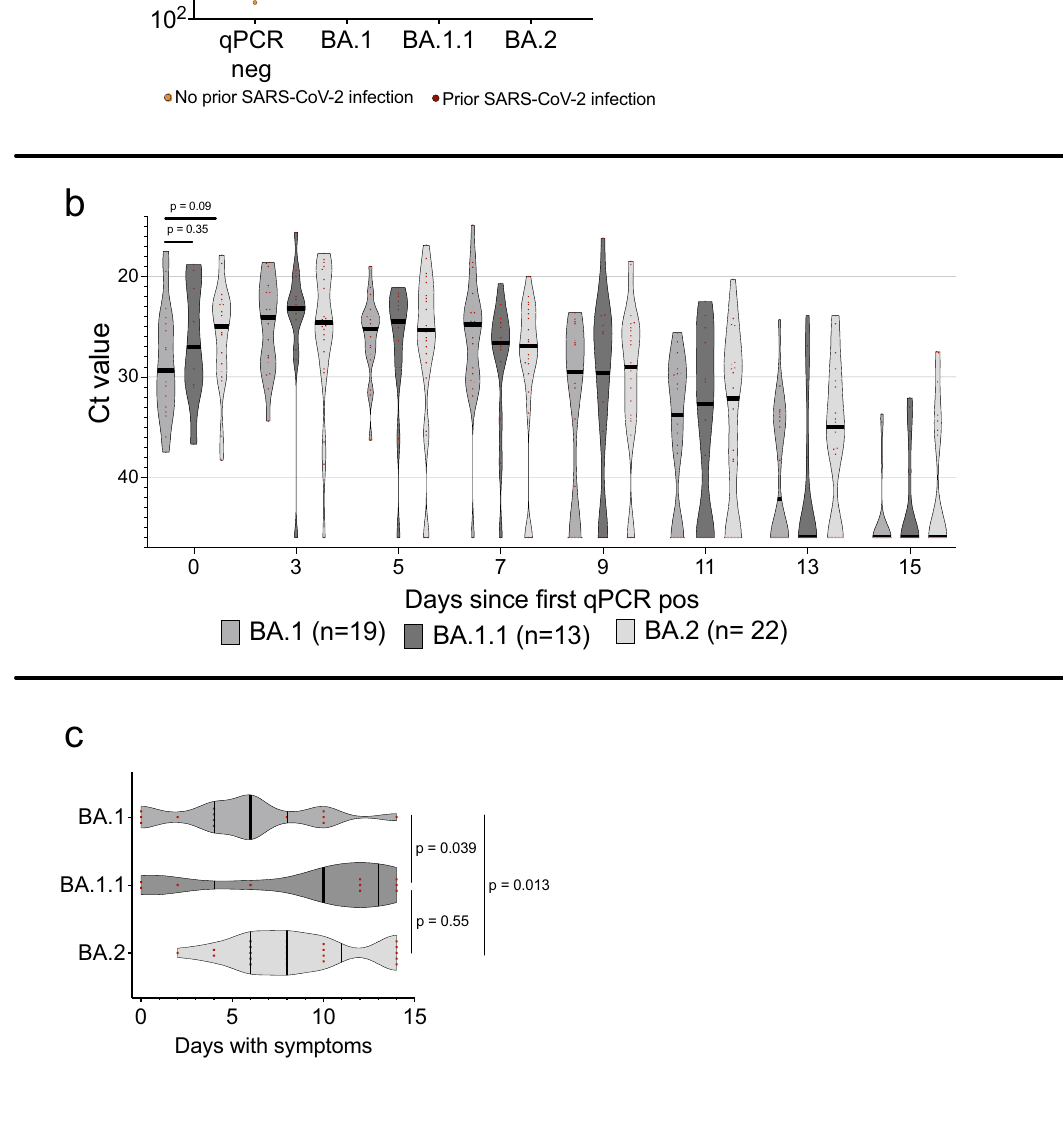
infection during the screening period.In ( a ),lines depict geometric meantiter and bars depict 95% con fi dence interval. In ( b ) and ( c ) lines depict median with IQR. Mann-Whitney U test with a two-tailed p -value was performed without adjustment for multiple comparisons. Pos Positive, Neg negative, S spike, WT wild-type, Ct cyclicthreshold,BAUbindingantibodyunits,ns; p >0.05.Sourcedataareprovided as a Source Data fi